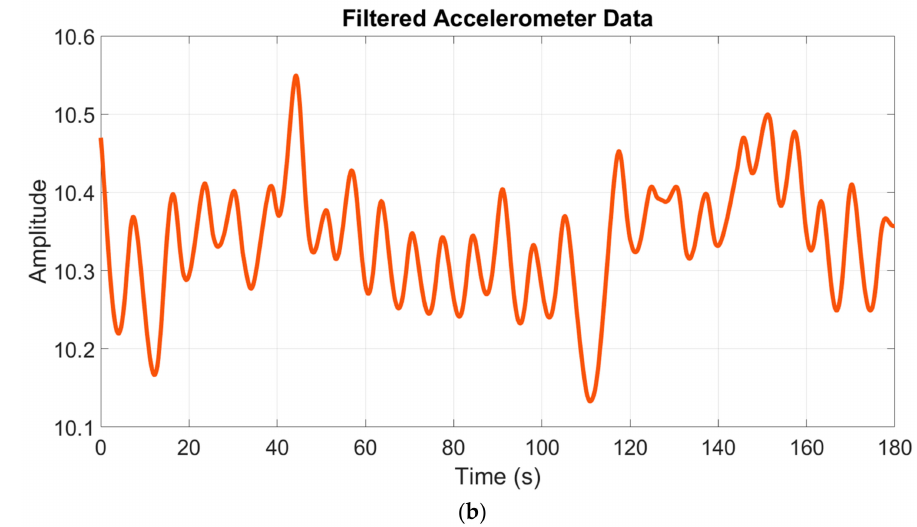
Figure 2. Thirty seconds of ( a ) raw and ( b ) filtered accelerometer data where the participant was walking